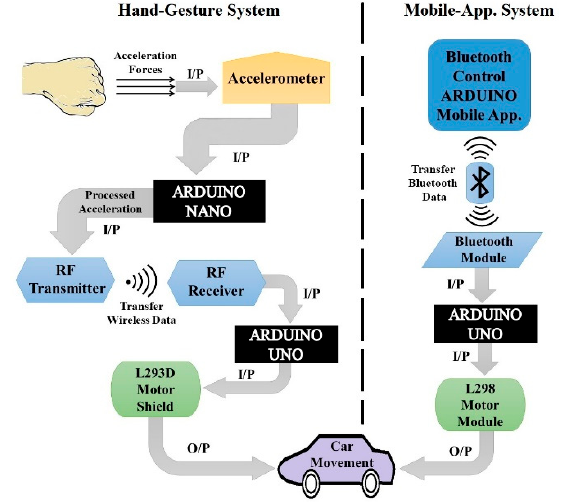
Figure 1. The architecture design of car controlling with hand-gesture and mobile application system.